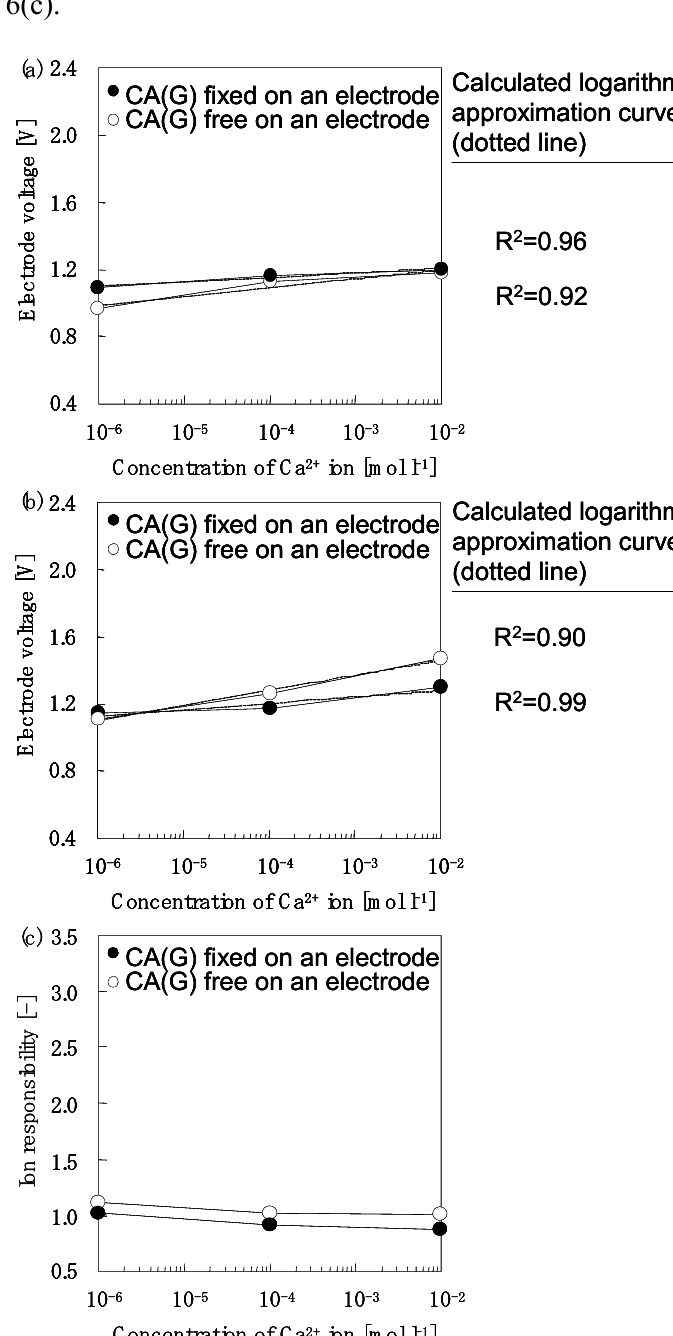
Figure 6. Example of the typical detection voltage of a type II host-guest reaction; a group of electrodes that show negative response. Detection of Ca 2+ by CA(G) adsorbed on an electrode surface are shown in Figure 6(a,b). Measurement sample: only one type of cation dissolved in distilled water (Figure 6(a)); cation dissolved in buffer solution (Figure 6(b)). Example of a typical ion response of a type II host-guest reaction is also shown in Figure 6(c). Calculated logarithm electrodeCA(G) fixed on an electrode electrodeCA(G) approximation curve CA(G) free on an CA(G) free on an (dotted line) (dotted line)